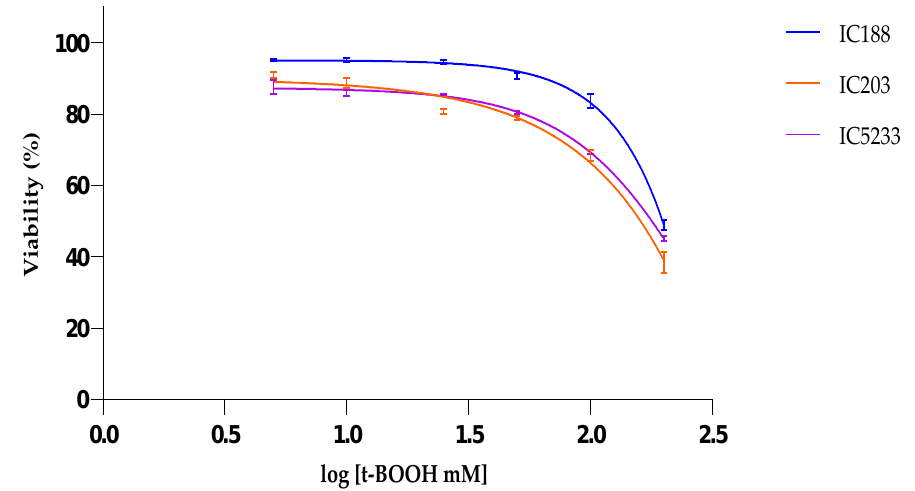
Figure 6. Flow cytometric assay of t-BOOH cytotoxicity to E. coli strains IC188, IC203 and IC5233. The curves represent the % of live cells versus the logarithm of the concentration. Results are mean ± SD (n = 3).